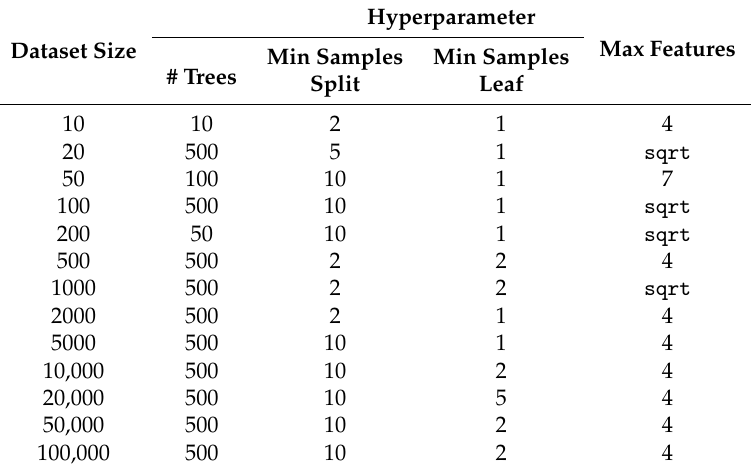
Table A3. Hyperparameters for random forest yielding the highest validation accuracy across dataset sizes. Note sqrt is the default number of features used per tree, which for 7 features rounds down to 2. Hyperparameter Dataset Size Min Samples Min Samples # Trees